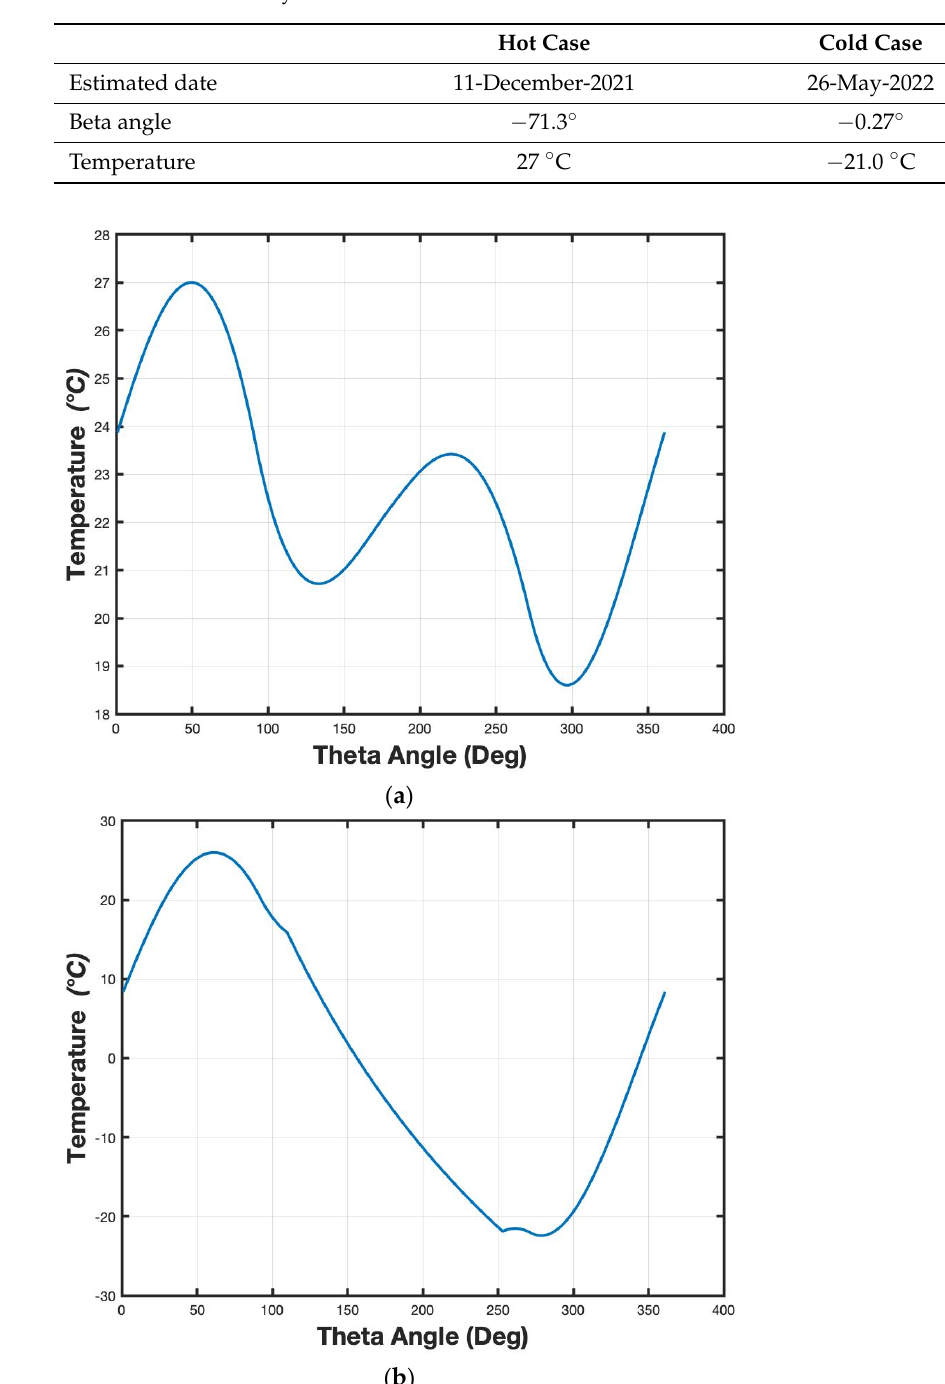
Figure 18. Temperatures that Light-1 can experience based on the thermal analysis: ( a ) hot case scenario and ( b ) cold case scenario.